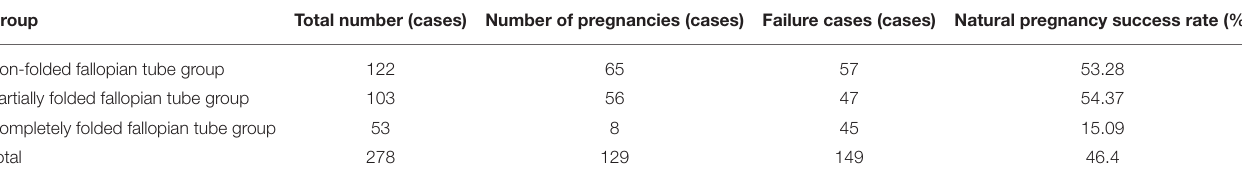
TABLE 2 | Fallopian tube distortion and post-operative pregnancy outcome.